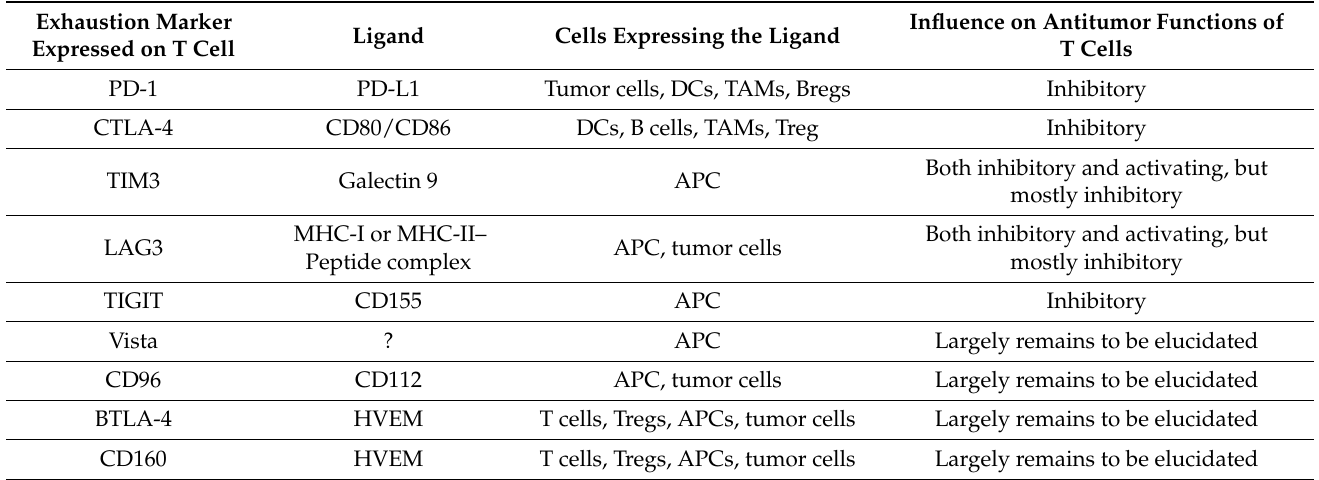
Table 2. Markers of T cell exhaustion and their ligands on different cell types